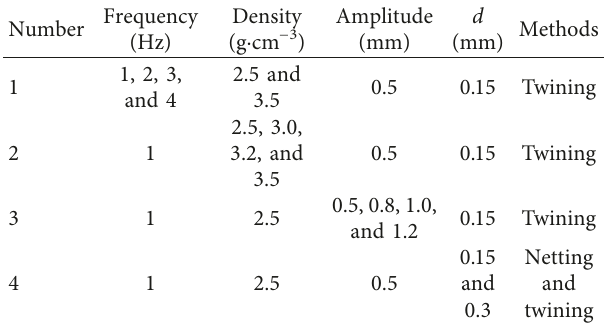
Table 1: Single-factor control test of MR test